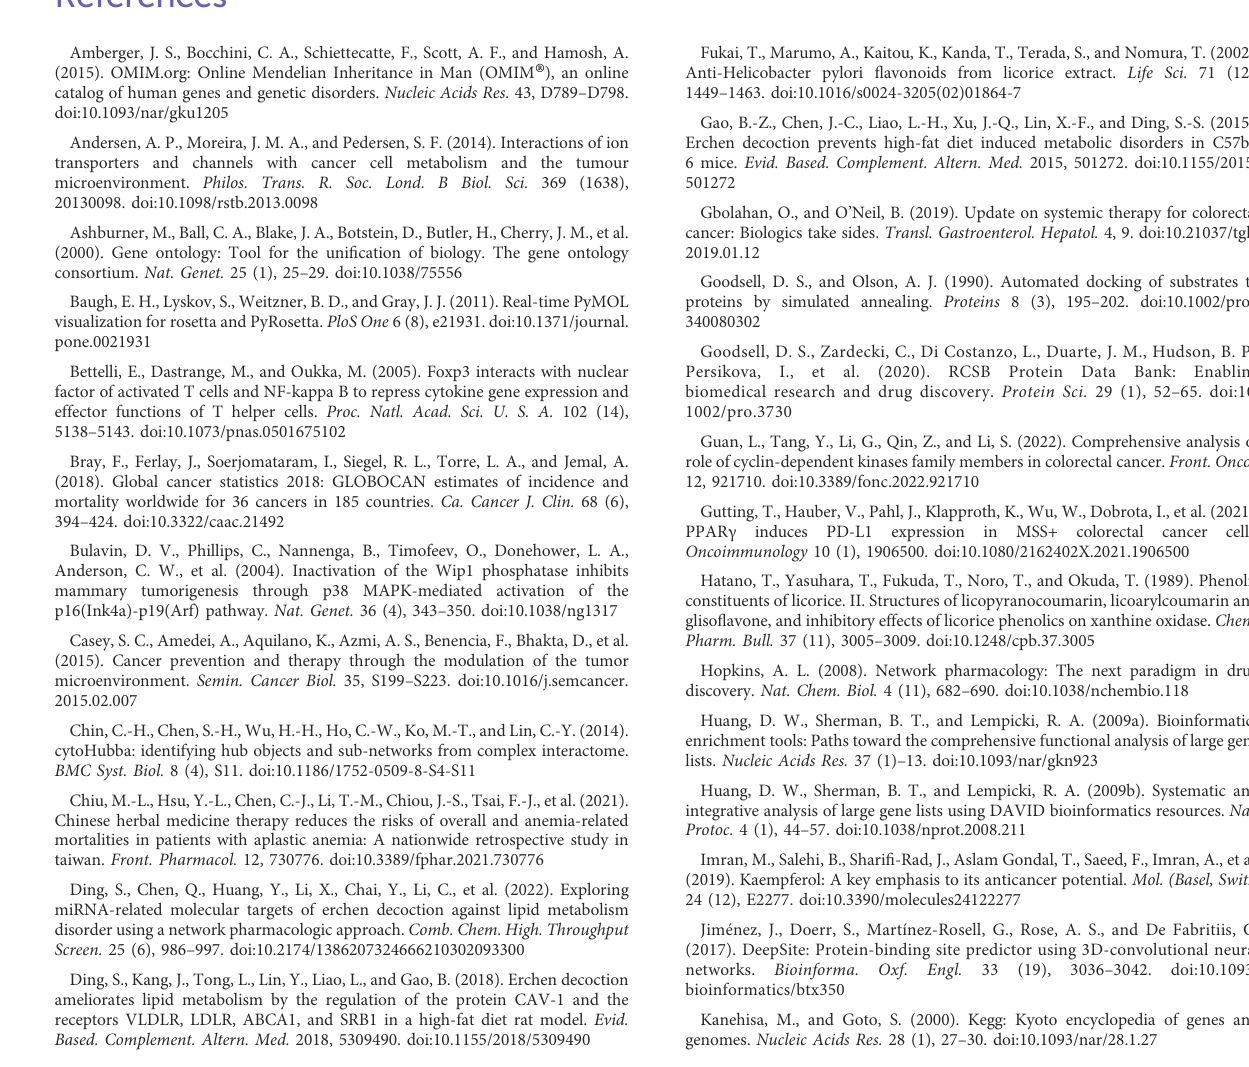
SUPPLEMENTARY FIGURE S1 The intersective targets between ECD and CRC. SUPPLEMENTARY FIGURE S2 The light microscopy images of CRC